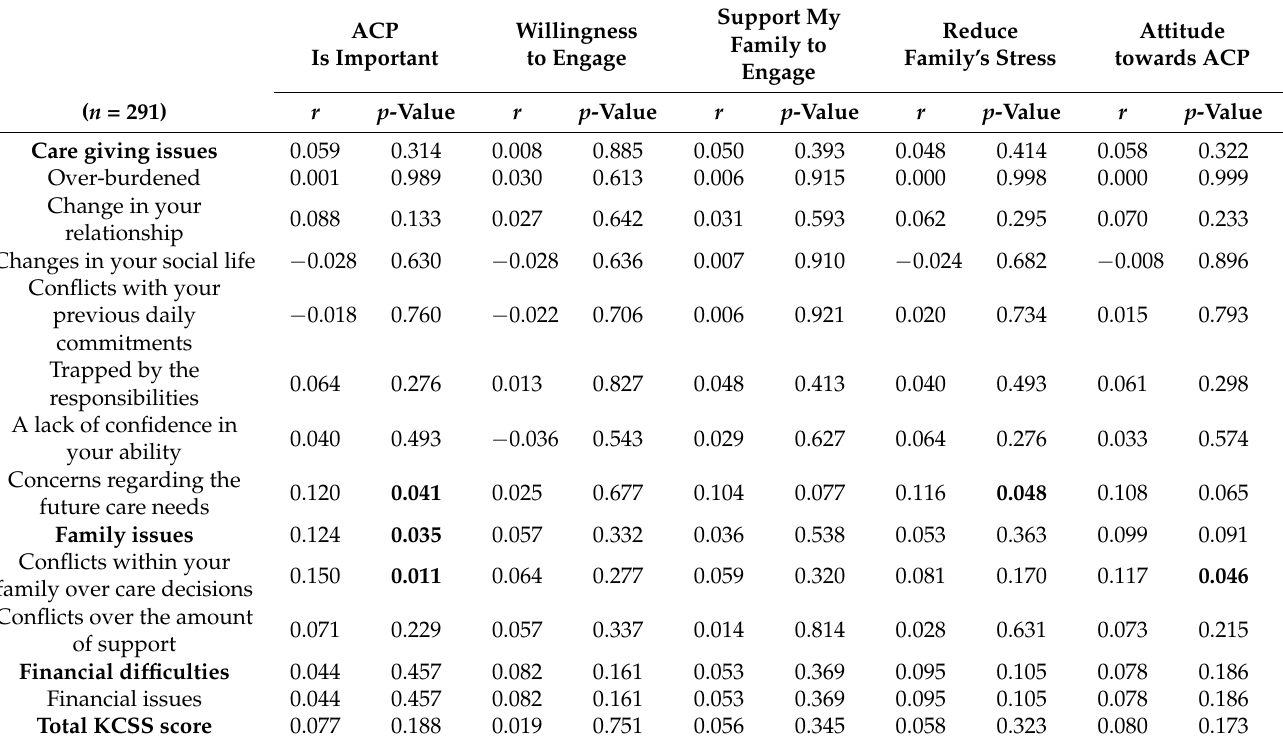
Table 2. The correlation between the caregiver stress and